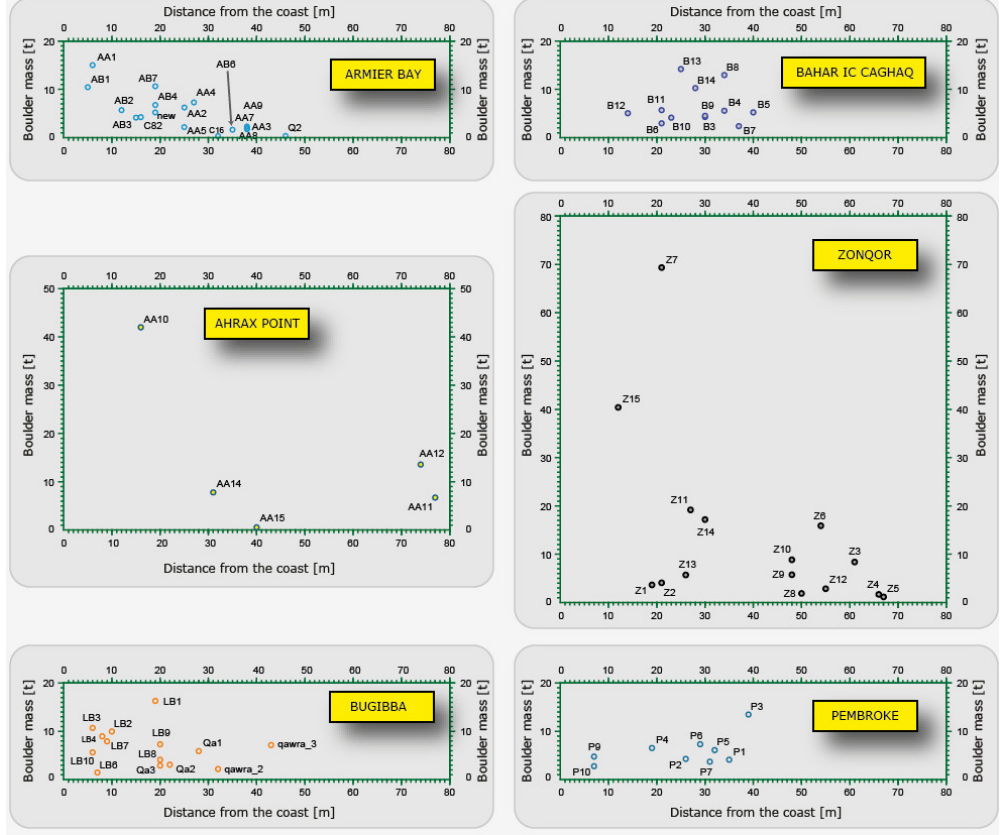
Figure 7. Relationship between the distance from the coast ( x ) and the boulder mass ( y